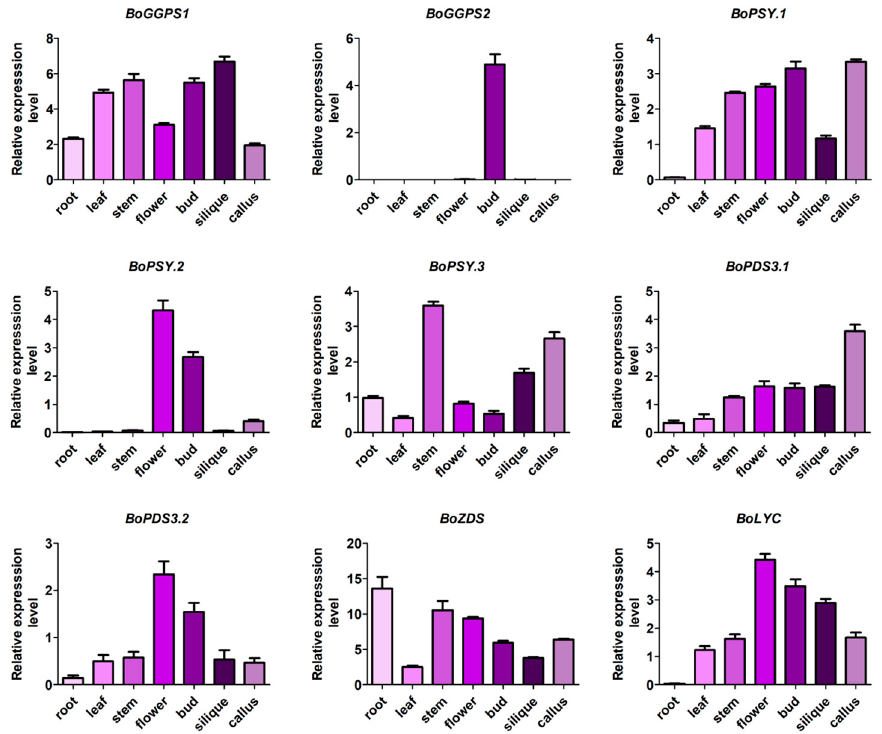
Figure 5. Relative expression levels of nine key carotenoid biosynthetic genes in different tissues of